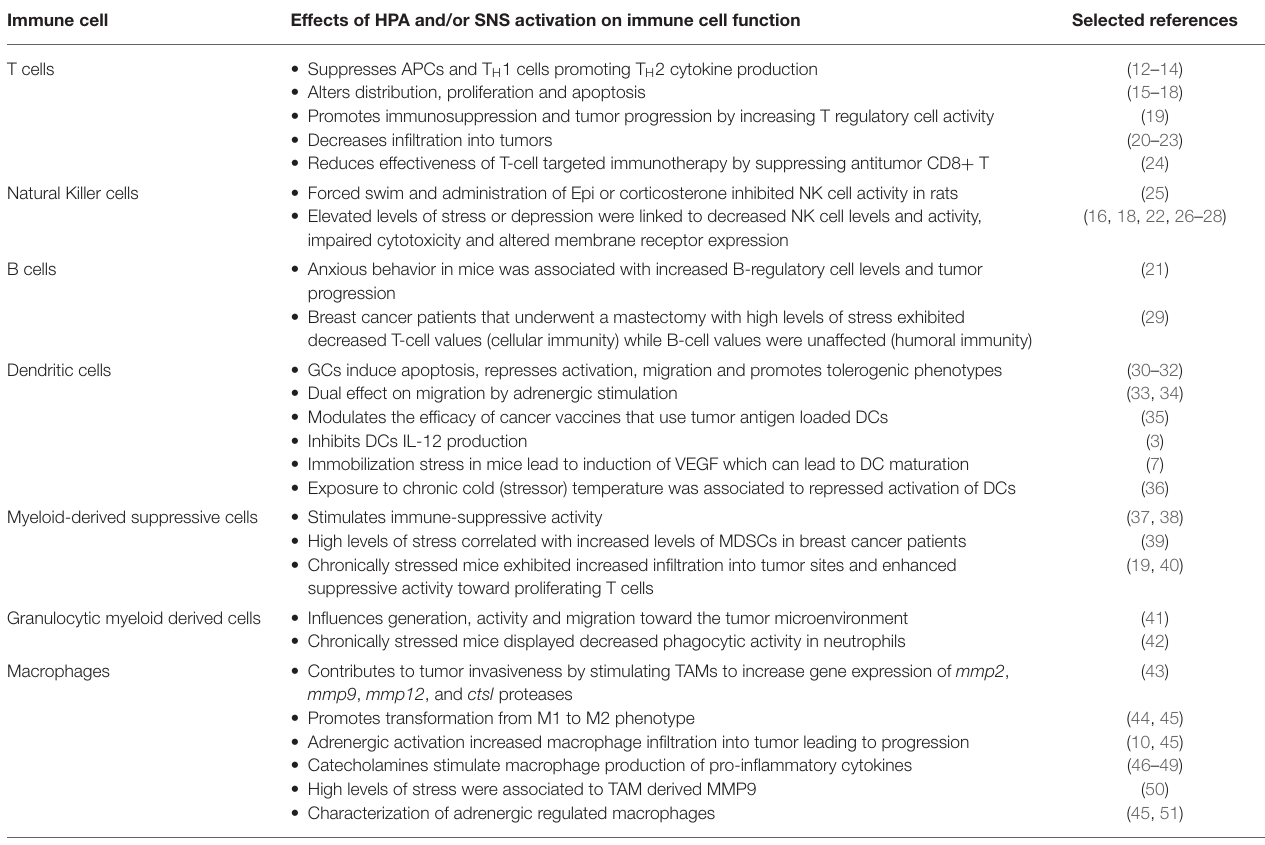
TABLE 1 | Neuroendocrine regulation of immune cell function in